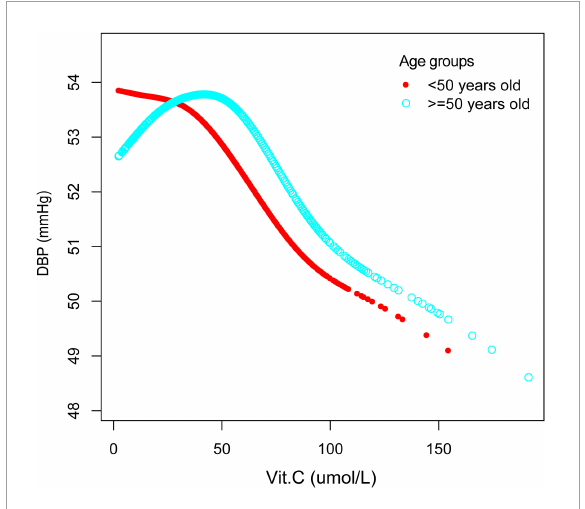
FIGURE6 The association between vitamin C and DBP, stratified by sex. Age, race/ethnicity, marital status, education level, ratio of family income to poverty, BMI, smoking states, pulse, ALT, ALP, AST, BUN, globulin, Cr, TG, TC, LDL, HDL, glycohemoglobin, TP, FBG, γ GT, and sUA were adjusted.